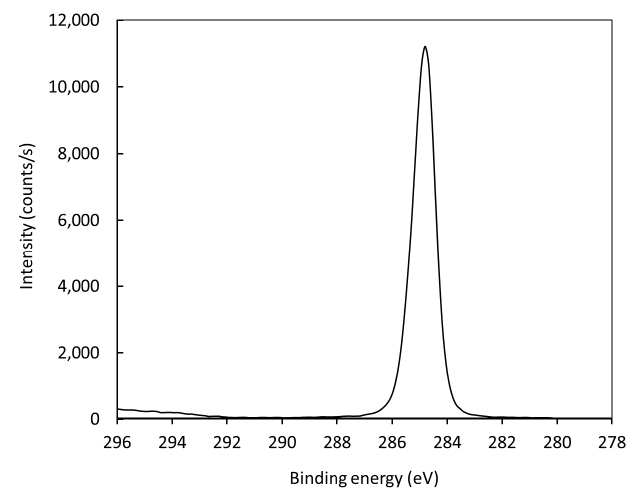
Figure 10. High-resolution C1s spectrum for an untreated sample.